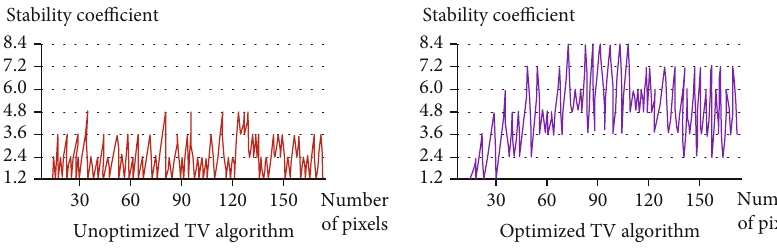
Figure 7: Comparison of TV algorithm without optimization and TV algorithm after optimization.